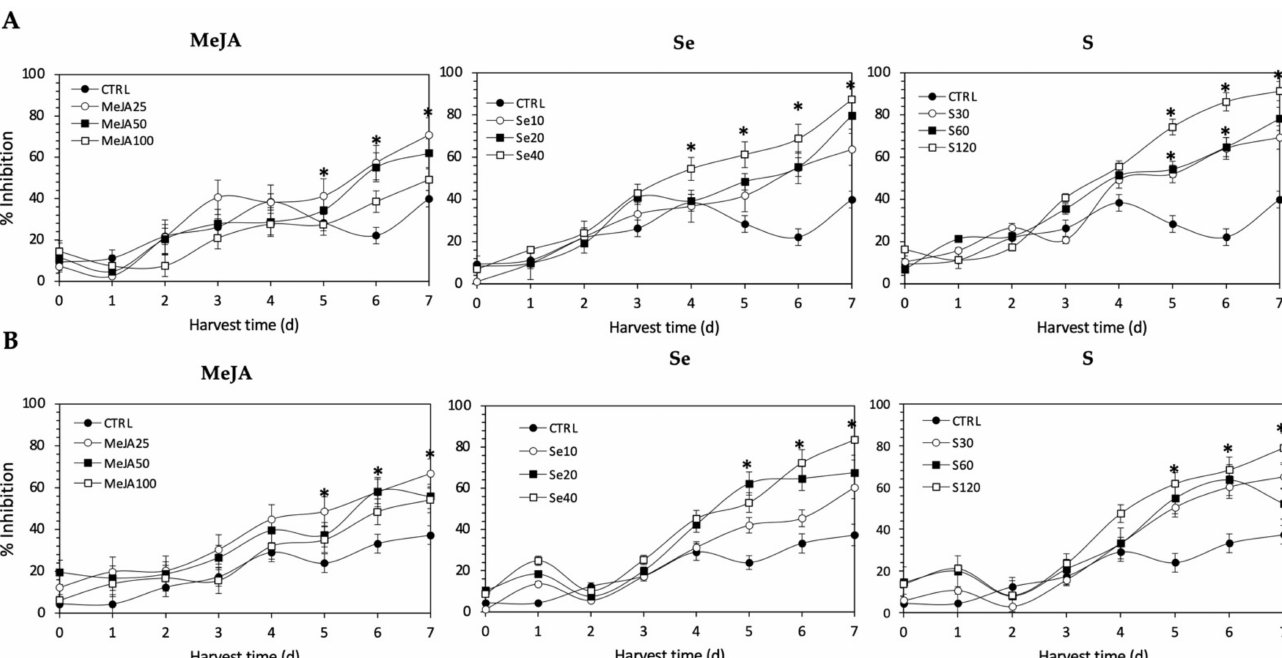
Figure 11. Iron chelating activity of ethanolic extract of ( A ) Red Russian and ( B ) Dwarf Green kale sprouts treated with (1) methyl jasmonate, (2) selenium, and (3) sulfur during the first 7 days of germination. Bars are means of 3 replicates ± standard error. Abbreviations: methyl jasmonate (MeJA), sulfur (S), selenium (Se), harvest time (HT). Data points with an asterisk “*” indicate statistical difference determined by a t -test ( p < 0.050) between the control and treated